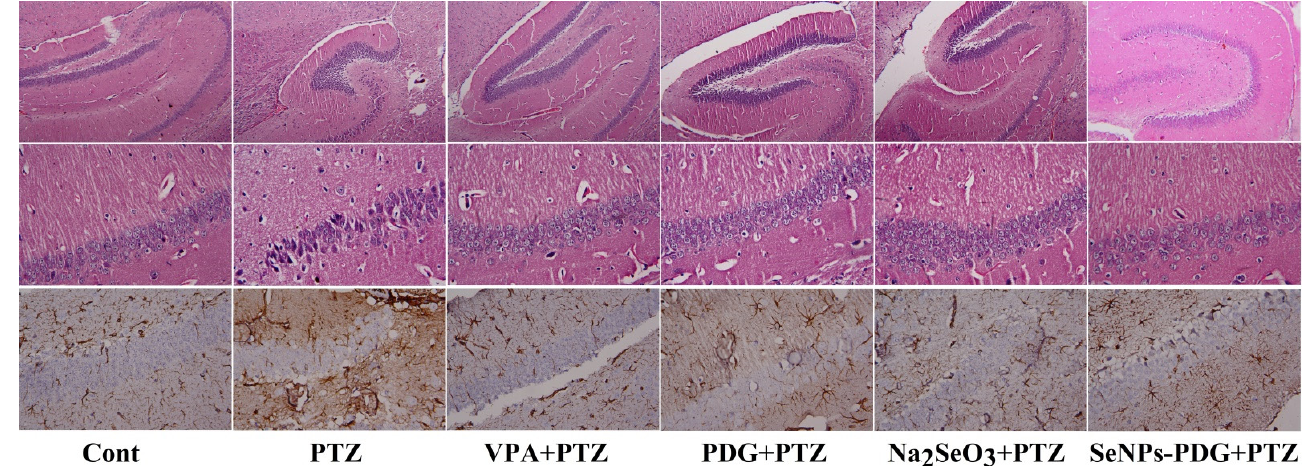
Figure 6. Effect of orally administered prodigiosin (PDG), sodium selenite (Na 2 SeO 3 ), and prodigiosin-conjugated with selenium nanoparticles (SeNPs-PDG) on histopathological changes top panel for hippocampus at ×200, middle panel for hippocampus at ×400, and bottom panel for GFAP expression (×400) in the hippocampal tissue following PTZ-induced epileptic seizures.